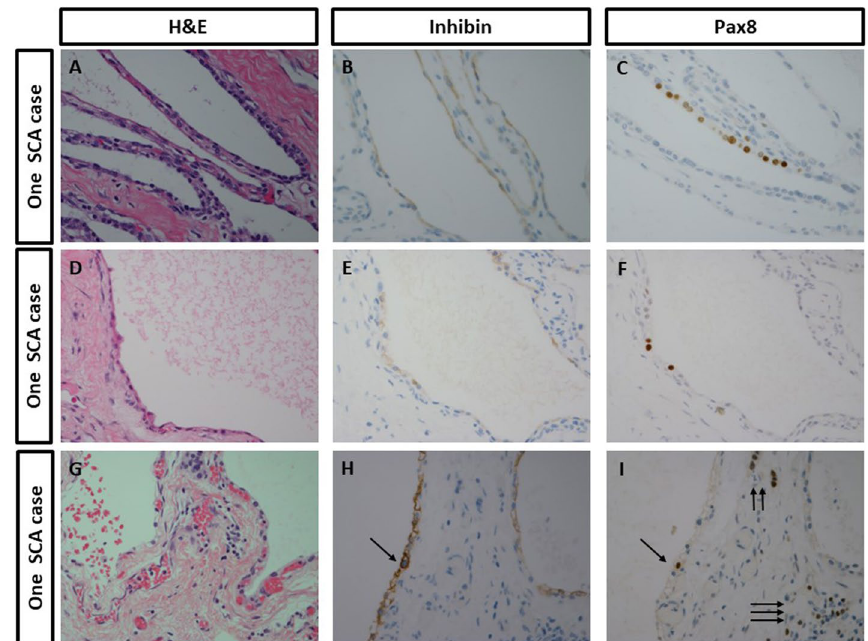
Fig. 1 Representative images from pancreatic serous cystadenoma (SCA) surgical resection cases. A – C One pancreatic SCA surgical resection case. D – F One pancreatic surgical resection SCA case. G – I One pancreatic SCA surgical resection case. A , D , and G Hematoxylin and eosin (H&E) staining. B , E , and H Inhibin. C , F , and I Pax8. H and I Single arrow: one pancreatic SCA cell; I double arrows: islet cells; triple arrows: lymphoid cells. Magnification 400 ( A – I ) = ×